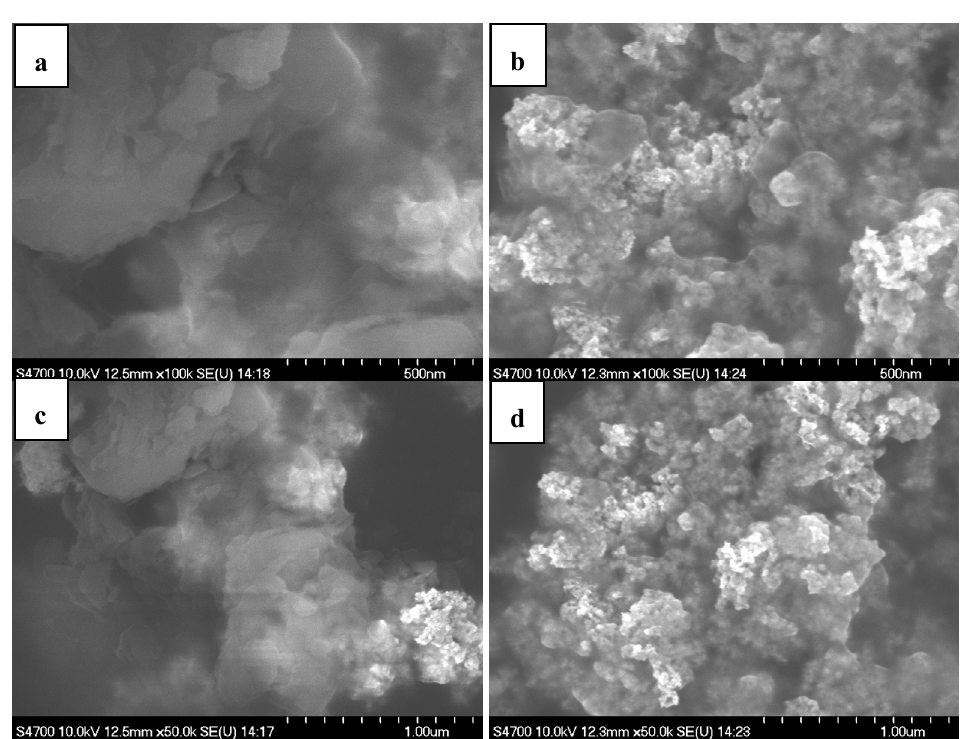
Figure 3. Scanning electron microscopy (SEM) images of two Pt/C catalytic